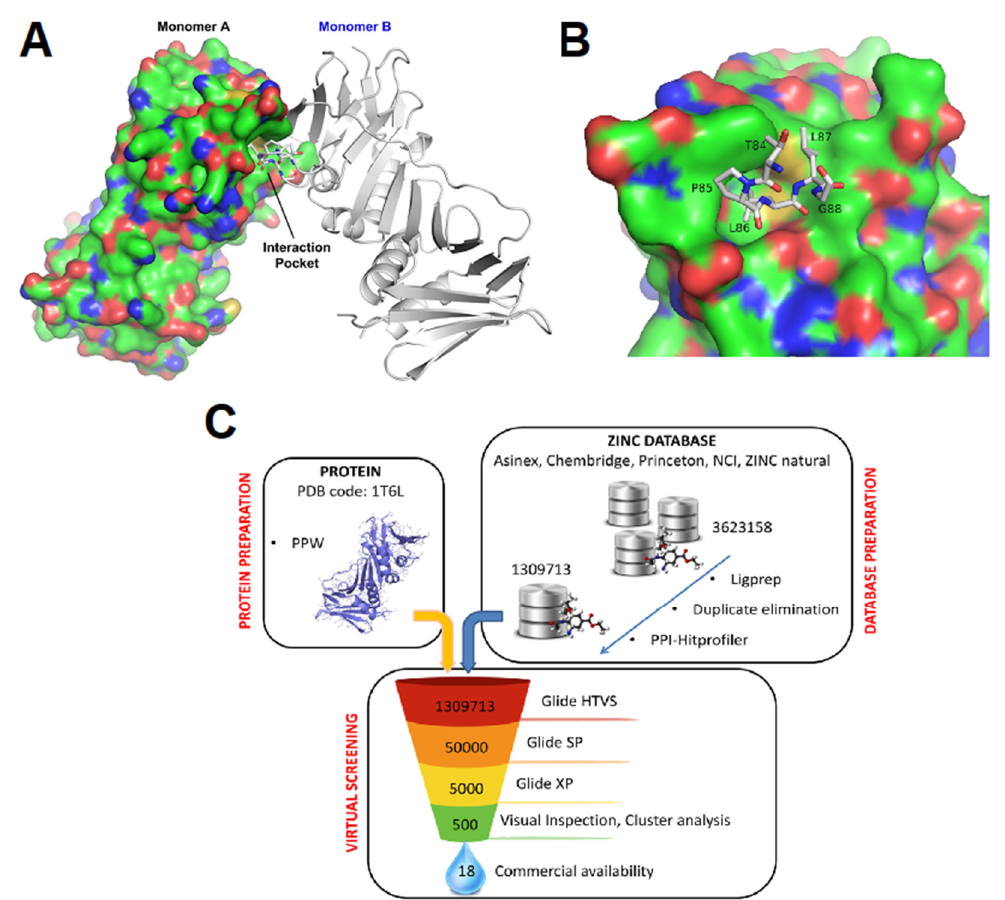
Figure 1. An in silico screening to identify SMs inhibiting ppUL44 dimerization. ( A ) Graphic representation of UL44(1-290) homodimers. One monomer is represented as surface (Monomer A), the other one as ribbons, with residues involved in dimerization being shown as sticks (Monomer B). ( B ) Inset of the homodimerization interface, with one monomer shown in surface and residues of the other monomer involved in the dimerization being shown as sticks. ( C ) Schematic overview of the virtual screening to identify SMs potentially disrupting UL44 homodimerization. The Glide software was used to dock molecules to the interface of the two monomers (PDB code: 1T6L). Three rounds of screening were performed using the High throughput virtual screening (HTVS), Standard Precision (SP), and Extra Precision (XP) docking settings. After each docking round, the top-ranked molecules in term of docking score were selected for the following round. The resulting 500 molecules were further filtered by visual inspection, cluster analysis and on the basis of their commercial availability, and 18 compounds were selected for further studies.